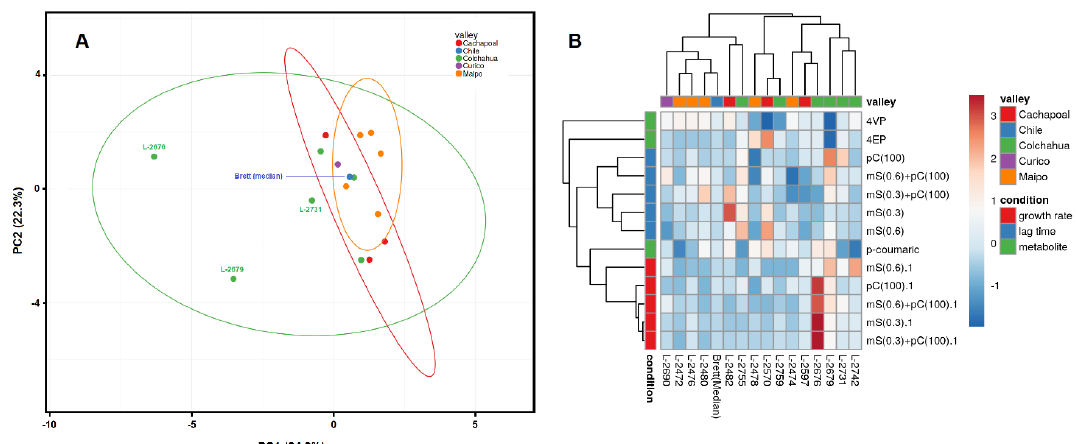
Figure 5. Multivariate analysis conducted on the basis of four physiological datasets of wine strains of Brettanomyces bruxellensis from Chile. Yeasts were cultivated in synthetic (YNB) medium supplemented with p -coumaric acid at 100 mg L − 1 for evaluation of p -coumaric acid consumption ( p -coumaric) (dataset 1) and production of 4-vinylphenol (4-VP) and 4-ethylphenol (4-EP) (dataset 2). Yeast cells were cultivated in synthetic media supplemented with p -coumaric acid 100 mg L − 1 (pC(100)), SO 2 0.3 mg L − 1 (mS(0.3)), SO 2 0.6 mg L − 1 (mS(0.6)), SO 2 0.3 mg L − 1 and p -coumaric acid 100 mg L − 1 (mS(0.3) + pC(100)) or SO 2 0.6 mg L − 1 and p -coumaric acid 100 mg L − 1 (mS(0.3) + pC(100)). Values were calculated